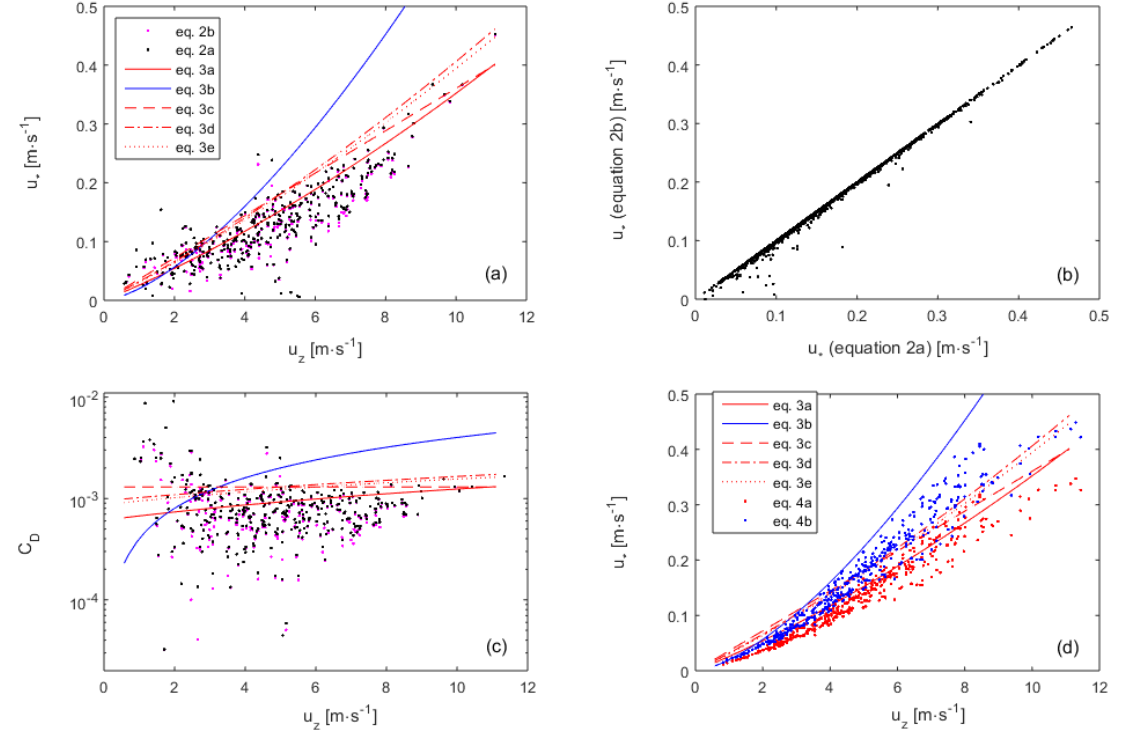
Figure 1. Estimated u * from E-C data [Equation (2a,b)], from wind speed at 10 m heights under atmospherically neutral conditions (u 10n ) and using drag coefficient (C D ) empirical formulations [Equation (3a–e)], or from the wave age [Equation (4a,b)]. Figure panels are: ( a , d ) estimated u* and its relation with wind observed at height z, ( b ) comparison between u* estimated by equations (2a) and (2b), ( c ) estimated drag coefficients.